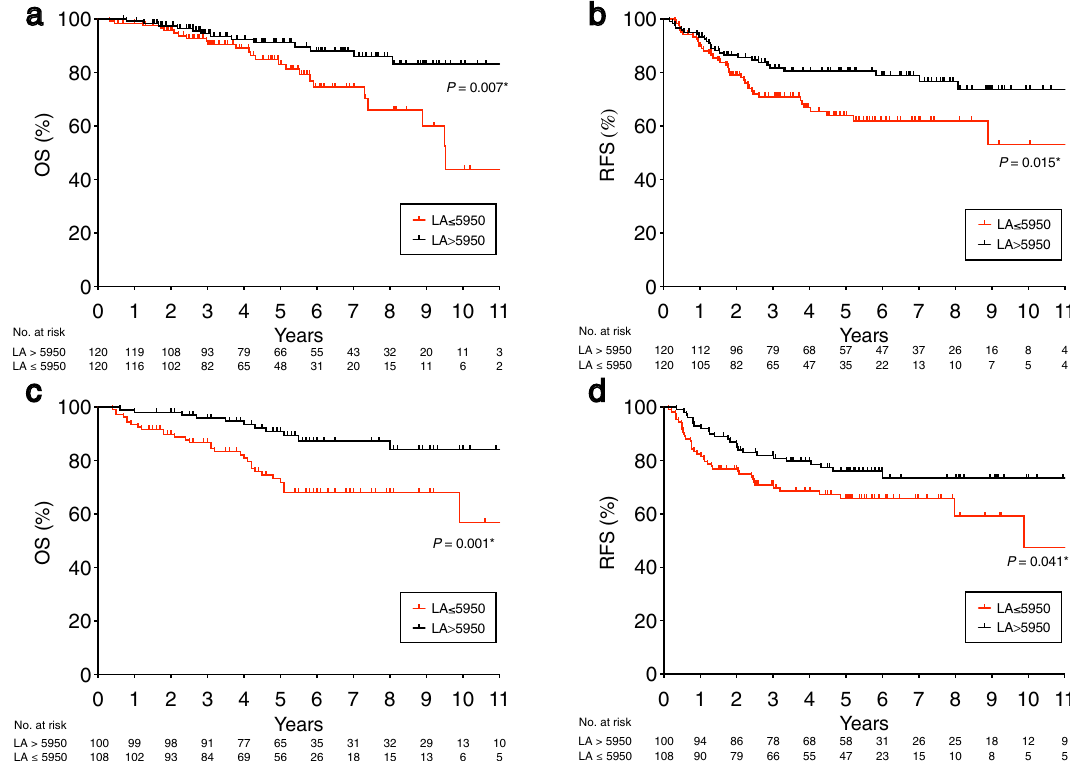
Figure 2. Prognostic impact of LA on OS and RFS in the discovery cohort ( a , b ) and validation cohort ( c , d ). Cox’s proportional hazard regression model. ( a , c ) LA > 5950 or ≤ 5950 for OS, ( b , d ) LA > 5950 or ≤ 5950 for